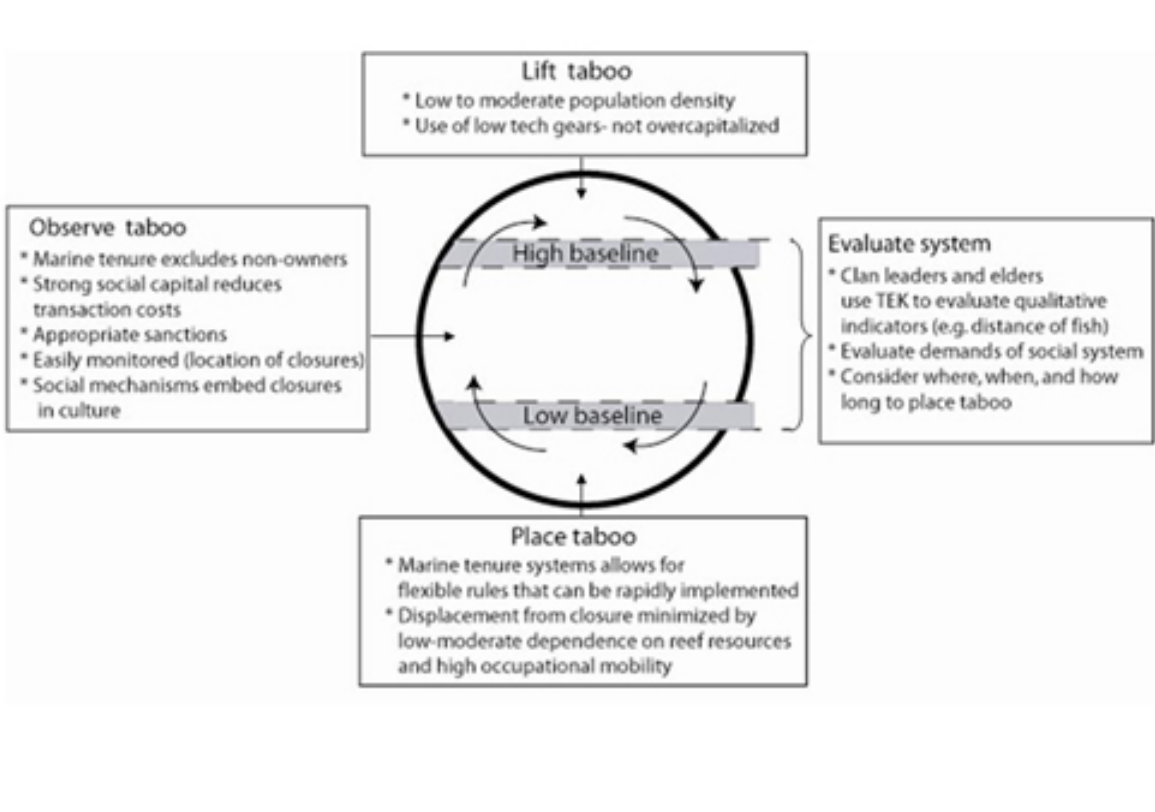
Fig. 5. Conceptual model of adaptive management phases. Each phase, i.e., placing, observing, and lifting the taboo, and evaluating the social-ecological system is facilitated by specific social, economic, and cultural